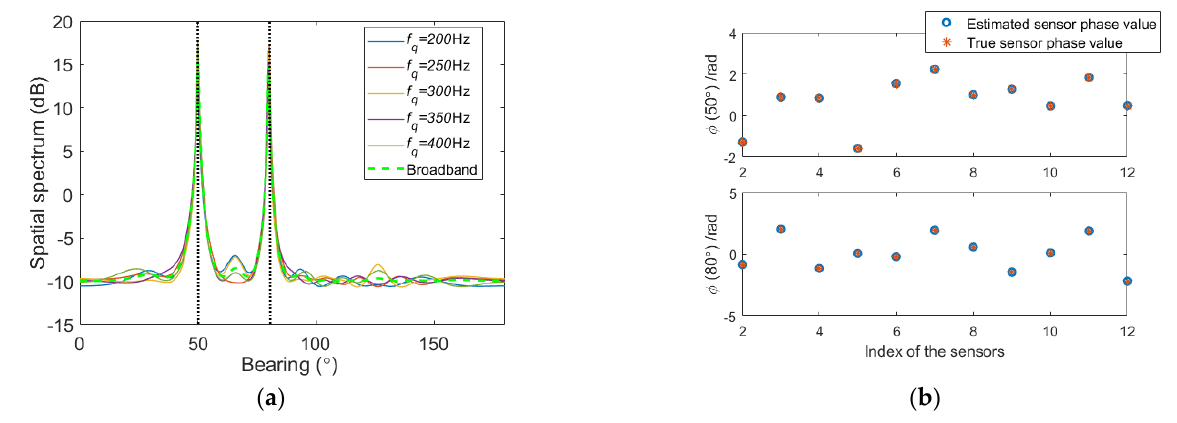
Figure 3. Estimated results: ( a ) spatial spectra; ( b ) DD sensor phase.